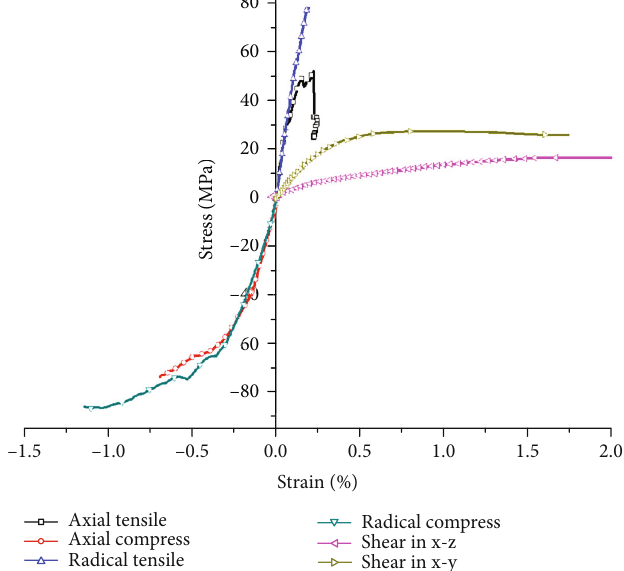
Figure 3: The typical stress-strain curves of axial braided C/C composites. Table 1: The parameters of the modi fi ed Jones-Nelson model of axial braided C/C composites.